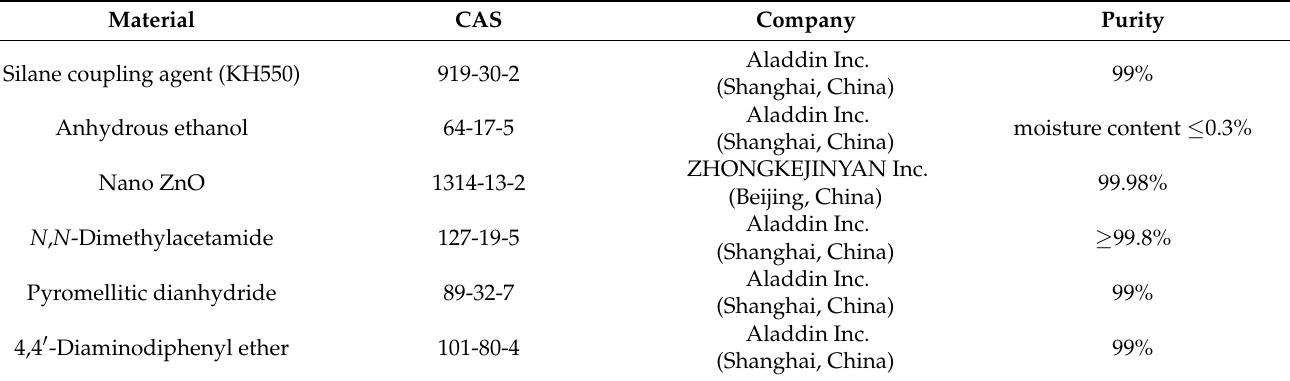
Table 1. Raw materials for the preparation of the PI